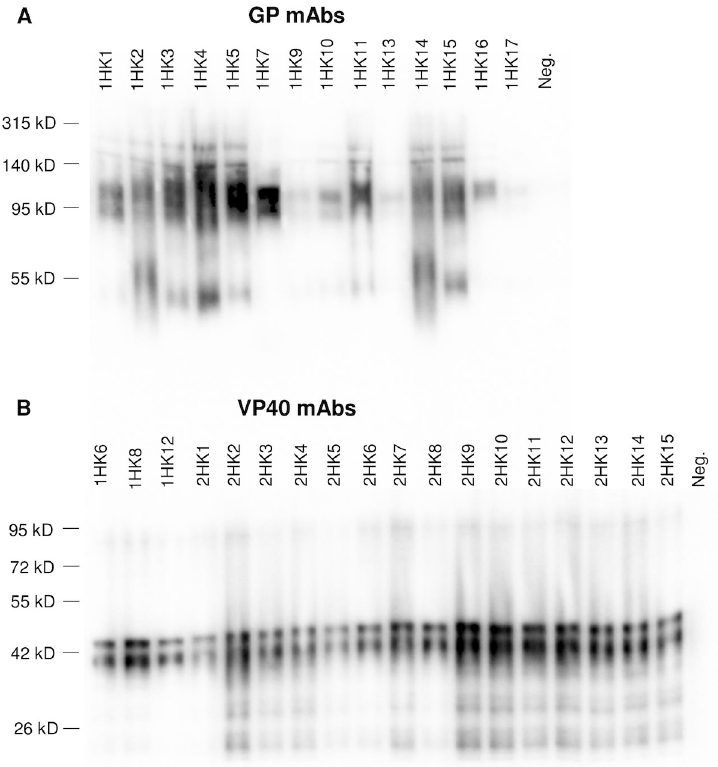
Fig 1. Western immunoblot analysis to evaluating monoclonal antibody (mAb) reactivity. mAb reactivity was assessed using 1 μ g recombinant GP (Panel A) or 0.5 μ g recombinant VP40 (Panel B).